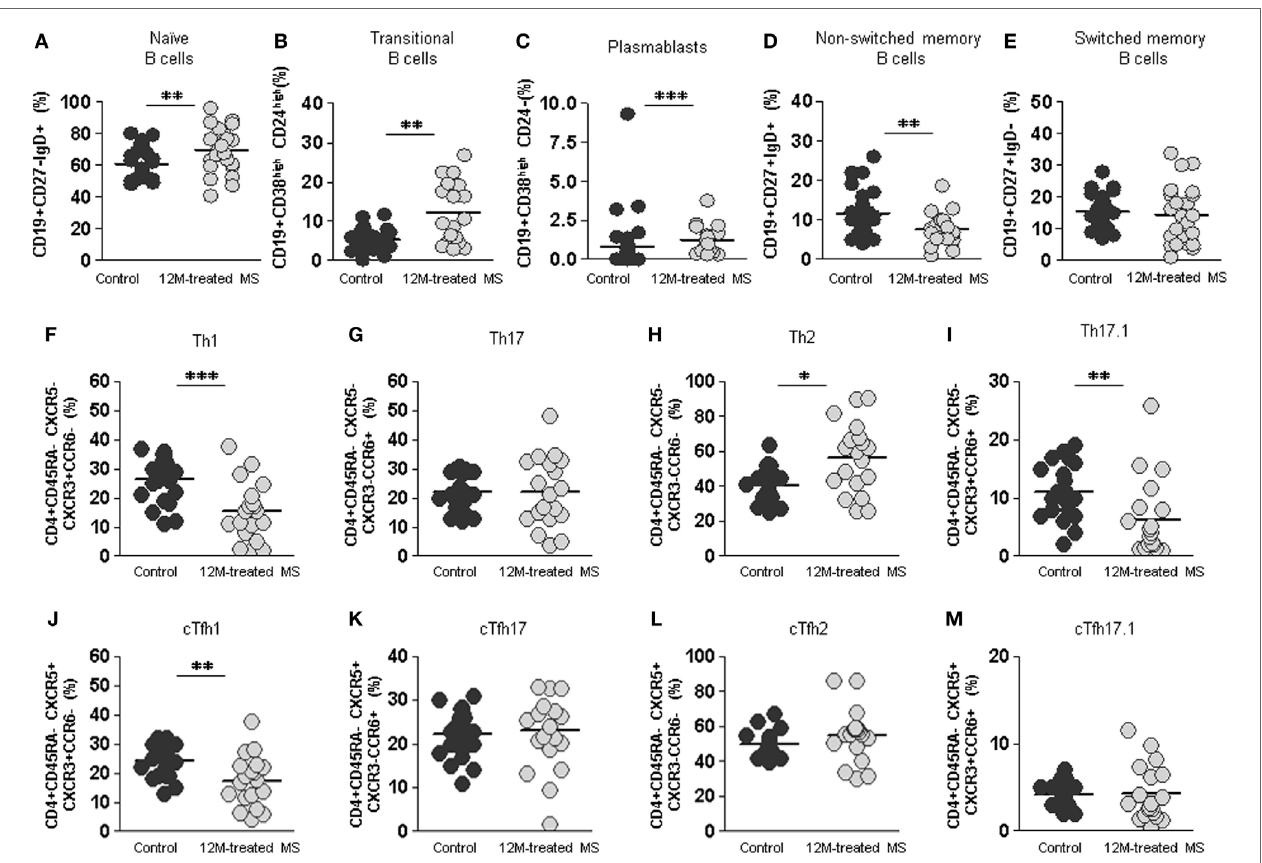
FigUre 7 | Final effect of dimethyl fumarate on B cell, non-follicular Th cells, and follicular cTfh cells subpopulations compared to healthy controls. (a–e) Percentages of naïve CD19 + CD27 − IgD + , transitional CD19 + CD38 high CD24 high , plasmablasts CD19 + CD38 high CD24 − , non-switched memory CD19 + CD27 + IgD + , and switched memory CD19 + CD27 + IgD − B cells from healthy controls (dark gray circles) and 12 months treated multiple sclerosis (MS) patients (12M: light gray circles). (F–i) Percentages of Th1, Th17, Th2, and Th17.1 non-follicular T cells and (J–M) percentages of cTfh1, cTfh17, cTfh2, and cTfh17.1 follicular T cells from healthy controls (dark gray circles) and 12 months treated MS patients (12M: light gray circles). Mann–Whitney U -test p -values: * p < 0.05, ** p < 0.01, and *** p <